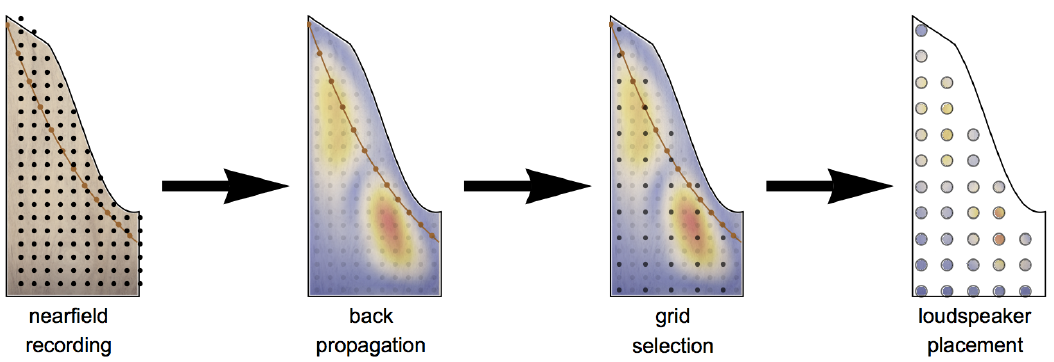
Figure 5. Procedure to derive the impulse response R f 1 ( Θ l , κ a , t ) for each loudspeaker and pressed key in the radiation keyboard. The brown curve represents the bridge, the brown dots depict exemplary excitation points. The black dots represent microphones near the soundboard, the light gray dots represent equivalent sources on the soundboard. The gray dots represent a regular subset of equivalent sources, which are replaced by loudspeakers (circles) in the radiation